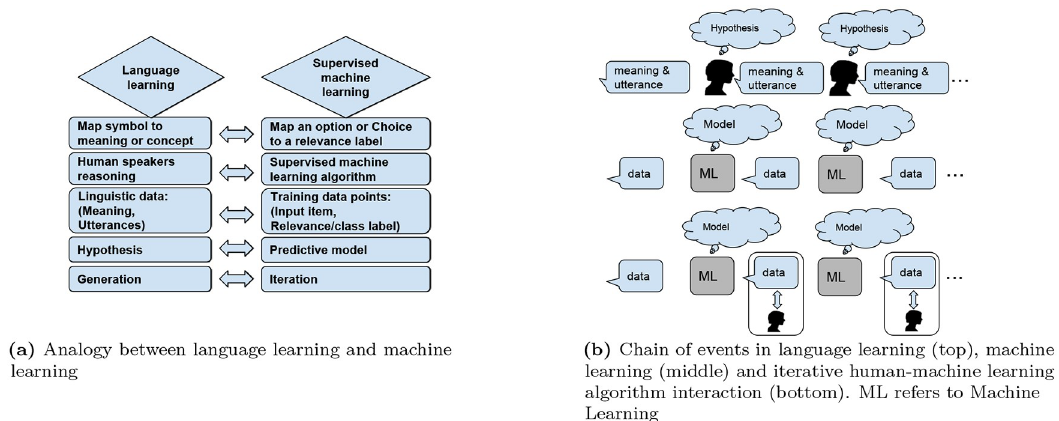
Fig 1. Language learning vs. machine learning. Language learning is analogous to machine learning in several aspects, such as ‘hypothesis’ to ‘model’ in sub-figure (a). Learning a language which gets transmitted throughout consecutive generations of human speakers is analogous to learning a model through consecutive iterations of online machine learning in sub-figure (b). In the iterative human-machine learning algorithm interaction, the output from ML affects human behavior and human also interact with the output which affects next